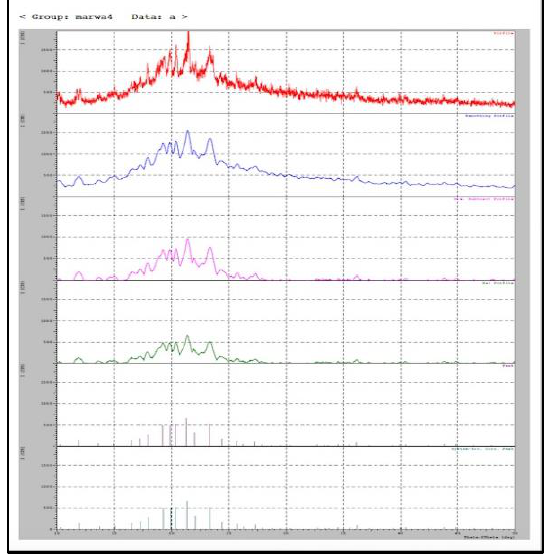
Figure 10. XRD characteristic peaks of atorvastatin calcium nanosuspension